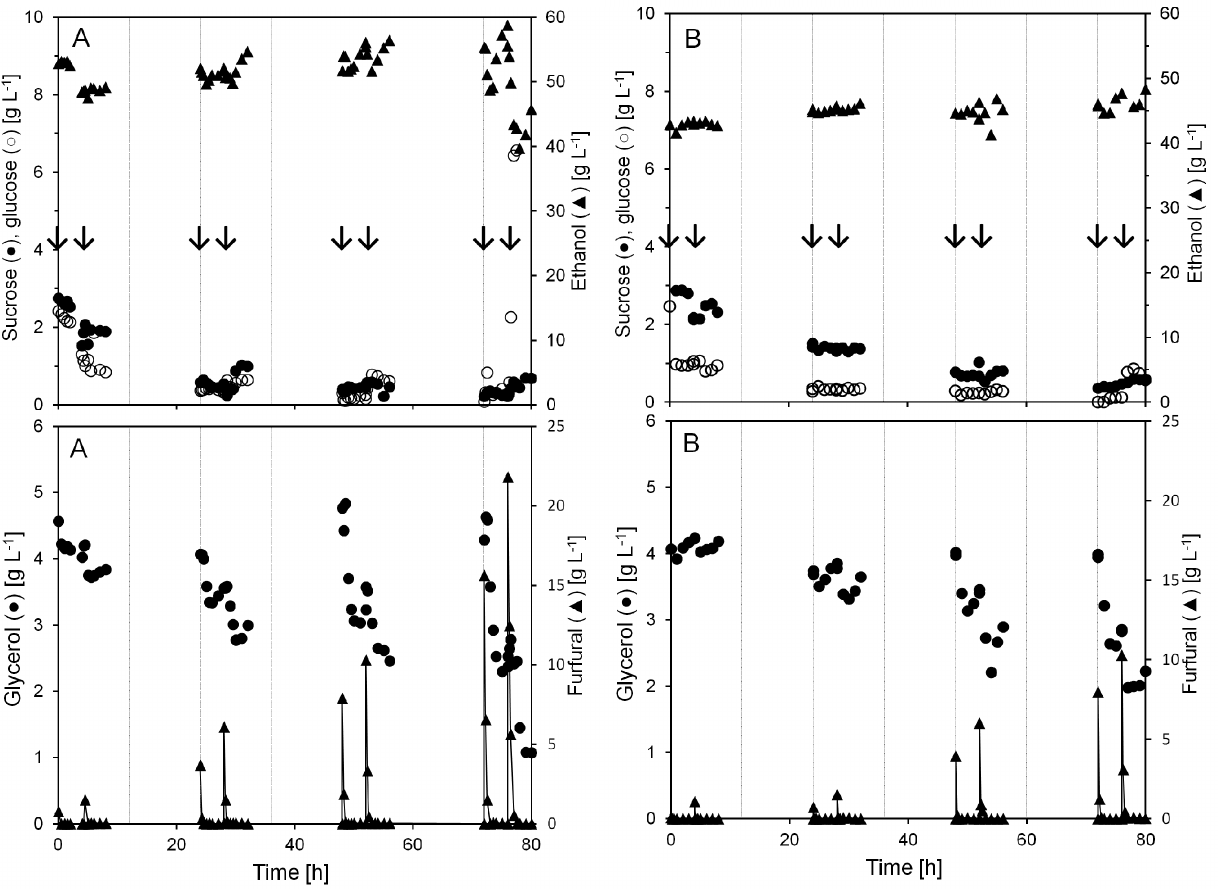
Figure 2. Concentrations of sucrose, glucose, ethanol, glycerol, and furfural during two anaerobic continuous cultivations with pulse injection of furfural (A and B). Each pulse injection of furfural is indicated by arrows. The gridlines denote each 12 h period in the continuous